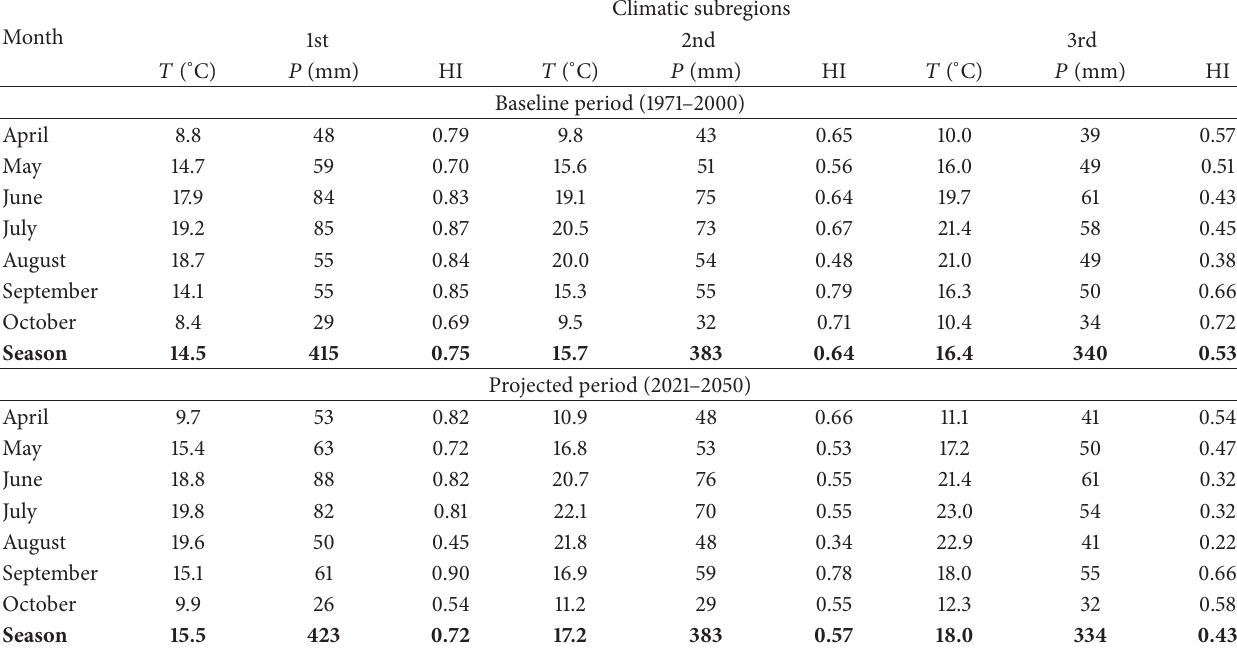
Table 2: Temperature and precipitation conditions of a warm season in the Moldavian part of the Dniester basin. Month